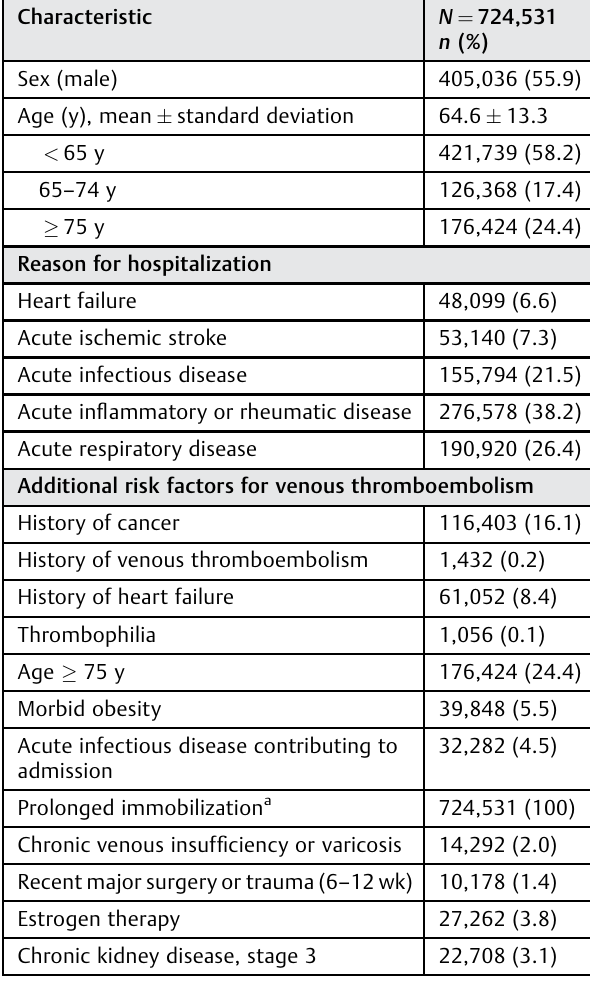
Table 1 Preindex hospitalization characteristics of included patients